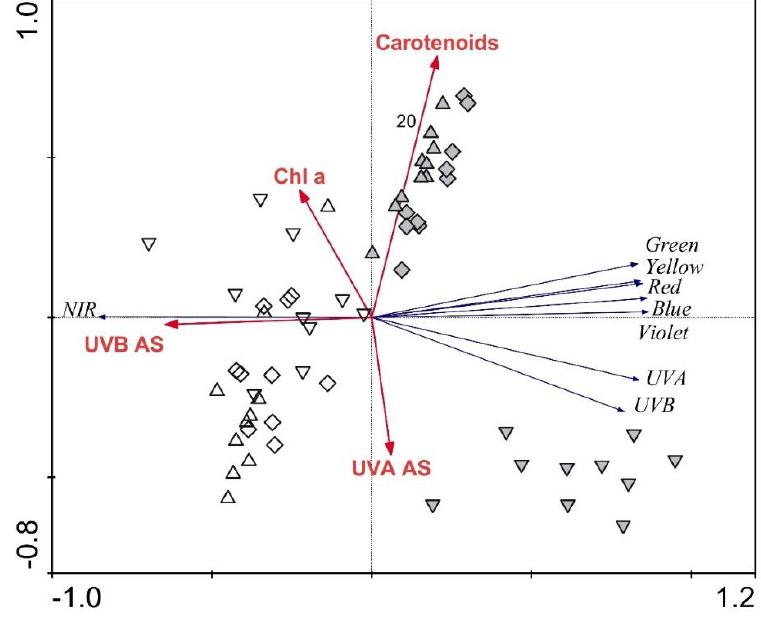
Figure 6. Redundancy analysis plot showing the strength of the associations between the frond traits and the regions of the transmittance spectra for Phyllitis scolopendrium . Up-triangles, specimens from the upper habitat; diamonds, specimens from the middle habitat; down-triangles, specimens from the lower habitat; white symbols, April samples; grey symbols, June samples; Chl a, chlorophyll a ; AS, absorbing substances; NIR, near-infrared.